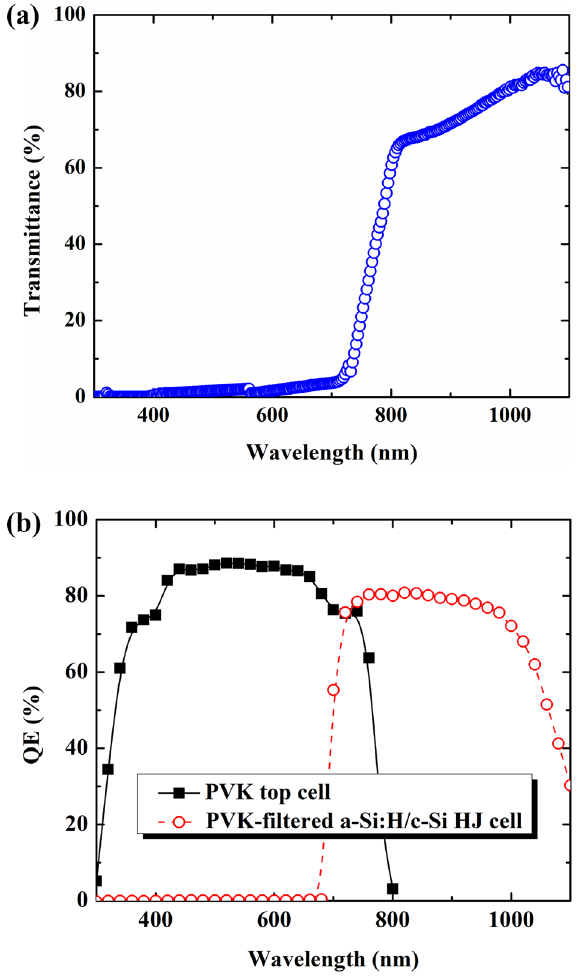
Figure 4. ( a ) Transmittance through perovskite top sub-cell solar cell. ( b ) Quantum efficiency of the PVK top sub-cell and of the PVK-filtered c-Si HJ solar